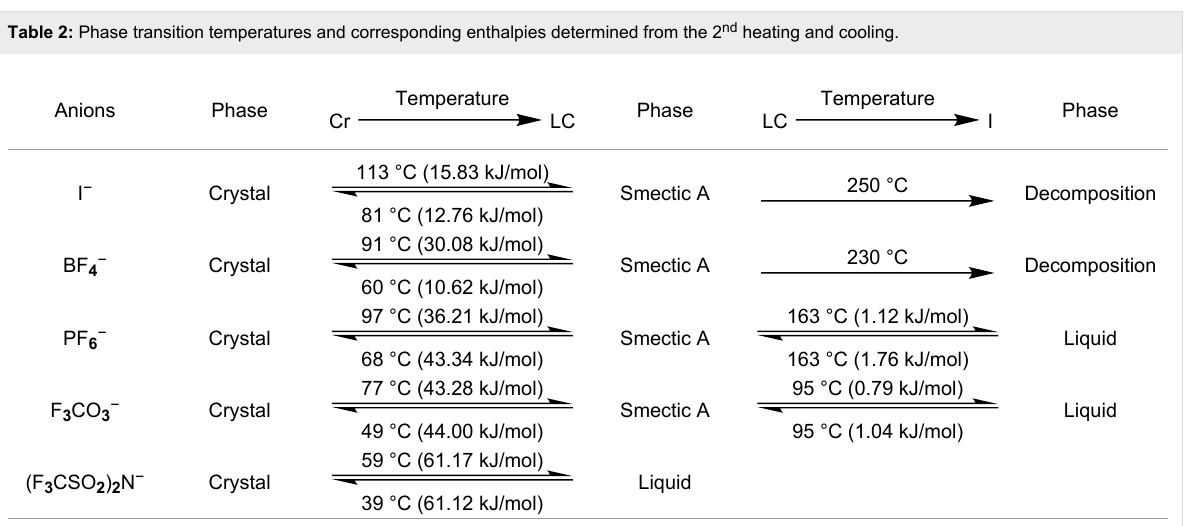
For all the compounds, the mesomorphic behaviour and phase transition temperatures were investigated by polarized optical microscopy (POM), differential scanning calorimetry (DSC), and powder X-ray diffractometry (XRD). To avoid possible effects of hydration of the materials, all were dried in vacuo before X-ray and DSC analyses. The phase transition tempera- tures and the corresponding enthalpy changes derived for compounds 1a–e are compiled in Table 2, while typical results are displayed in Figure 5.